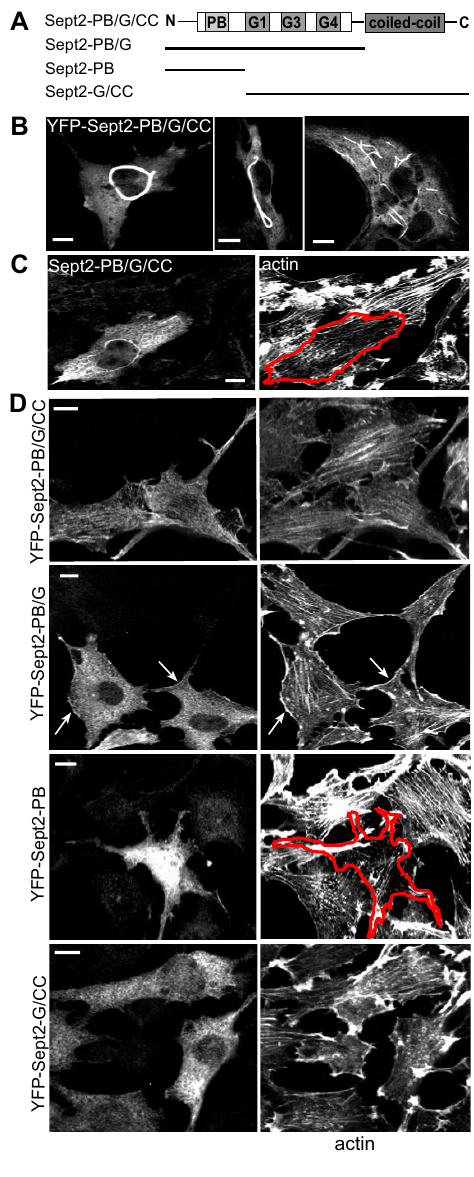
Figure 3 Characterisation of truncated YFP-Septin2 constructs. (A) Schematic presentation of full length YFP-Septin2 (YFP- Sept2-PB/G/CC) and truncated YFP-Septin2 constructs. (B) In some cells overexpression of full length YFP-Sept2-PB/G/CC induced the formation of higher-ordered YFP-Septin2 containing-structures with differing morphology (C) Untagged full length Sept2-PB/G/CC is also capable of forming these structures and actin filaments are attenuated in those cells. Full length Sept2- PB/G/CC was detected with anti-Septin2-antibody. (D) Distribution of YFP-Septin2 constructs in NRK cells and their effect on the actin cytoskeleton. Cells were transfected with either full length YFP-Sept2-PB/G/CC or the truncated YFP-Septin2 con- structs and stained for actin with phallacidin. Only YFP-Sept2-PB, the construct lacking the GTPase domain and the coiled coil domain affects actin organisation. The distributions of YFP-Sept2-PB/G, the construct without the coiled-coil domain, and YFP- Sept2-G/CC, which lacks the polybasic region, are different to full length YFP-Sept2-PB/G/CC, but there is no effect on actin. Images show a single confocal section. Bars. 10 µ